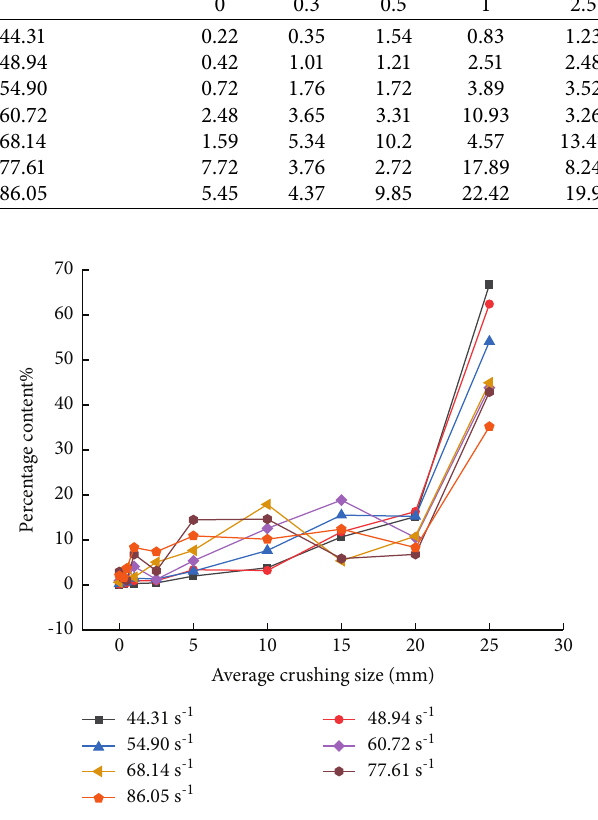
Figure 6: Fragmentation distribution of dolomite marble under different strain rates.